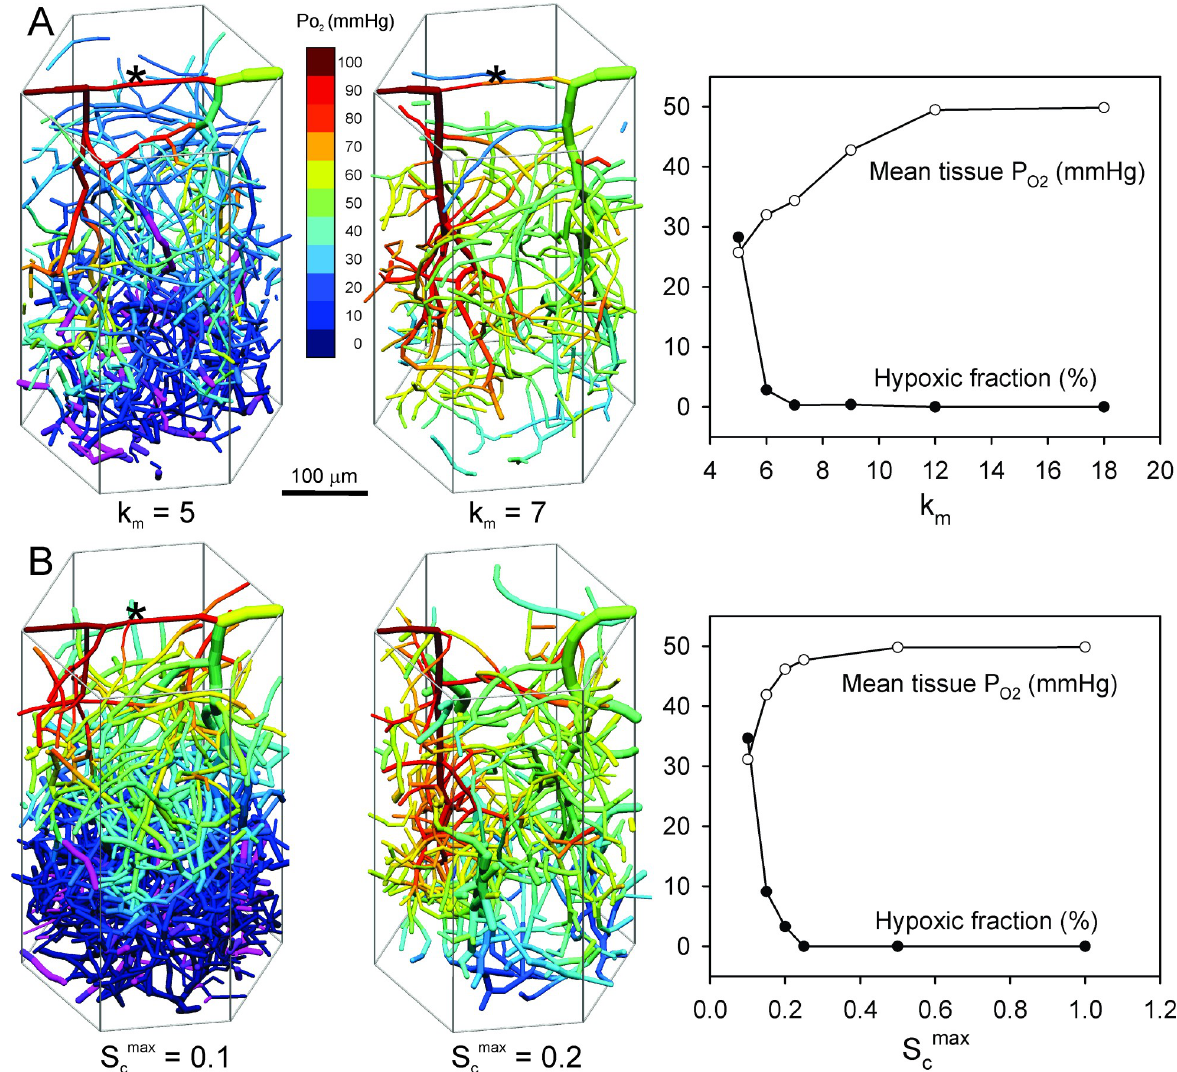
Fig 5. Effects of reduced metabolic responses. Graphs show values of mean tissue P O2 and hypoxic fraction at end of simulation at 10 days (2 days for the case S cmax = 0.1). Examples of final network structures, color-coded for vessel P O2 , are shown at left of each graph. Asterisk ( � ) indicates retention of pial A-V connection. (A) Effect of reducing strength of metabolic response ( k m ) while holding total flow nearly constant. (B) Effect of reducing relative strength of upstream conducted response ( S cmax ) while holding total flow nearly constant.